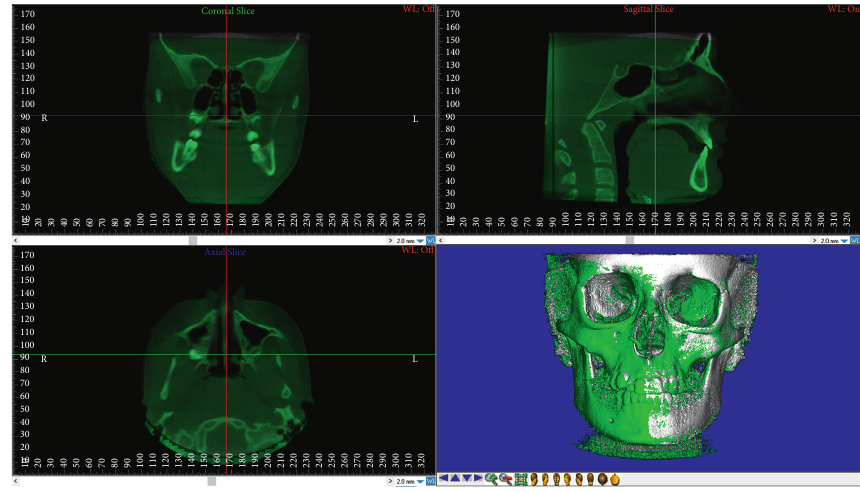
Figure 5: Voxel-based superimposition